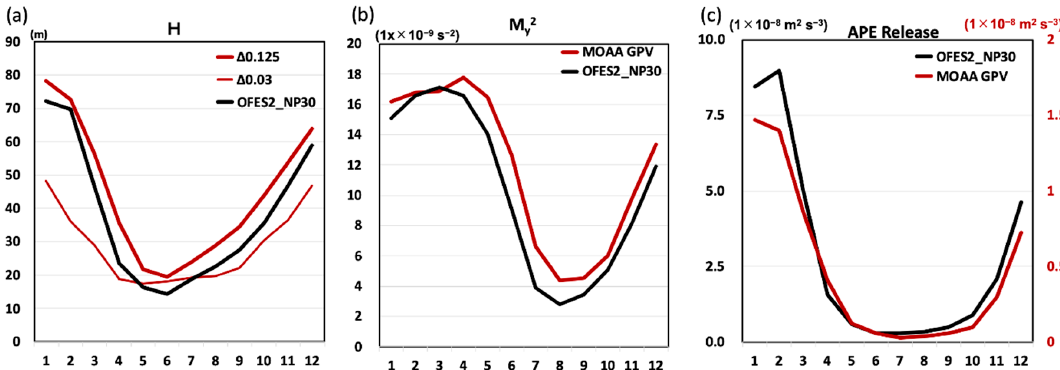
Figure 10. Monthly climatology of ( a ) MLD (H), ( b ) meridional buoyancy gradient (M y2 ), and ( c ) parameterized APE release based on the Grid Point Value of the Monthly Objective Analysis using the Argo data (MOAA GPV) averaged from 2005 to 2016 (red curves) and OFES2 averaged from 1991 to 2016 (black curves). The MLD in MOAA GPV (red thick curves) and OFES2 (black curves) are defined by the depths with density changes from the surface of 0.125 σ θ and 0.03 σ θ , respectively. Another MLD in MOAA GPV with red thin curve in ( a ) is defined by the same as that in OFES2.